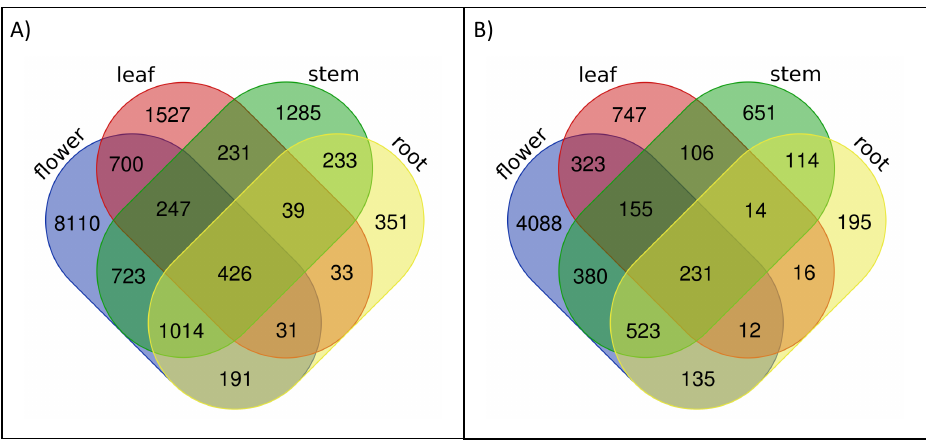
Figure 2. Overlap of the DEGs in ( A ) and rSNPs in ( B ) for the four investigated tissues (visualized with